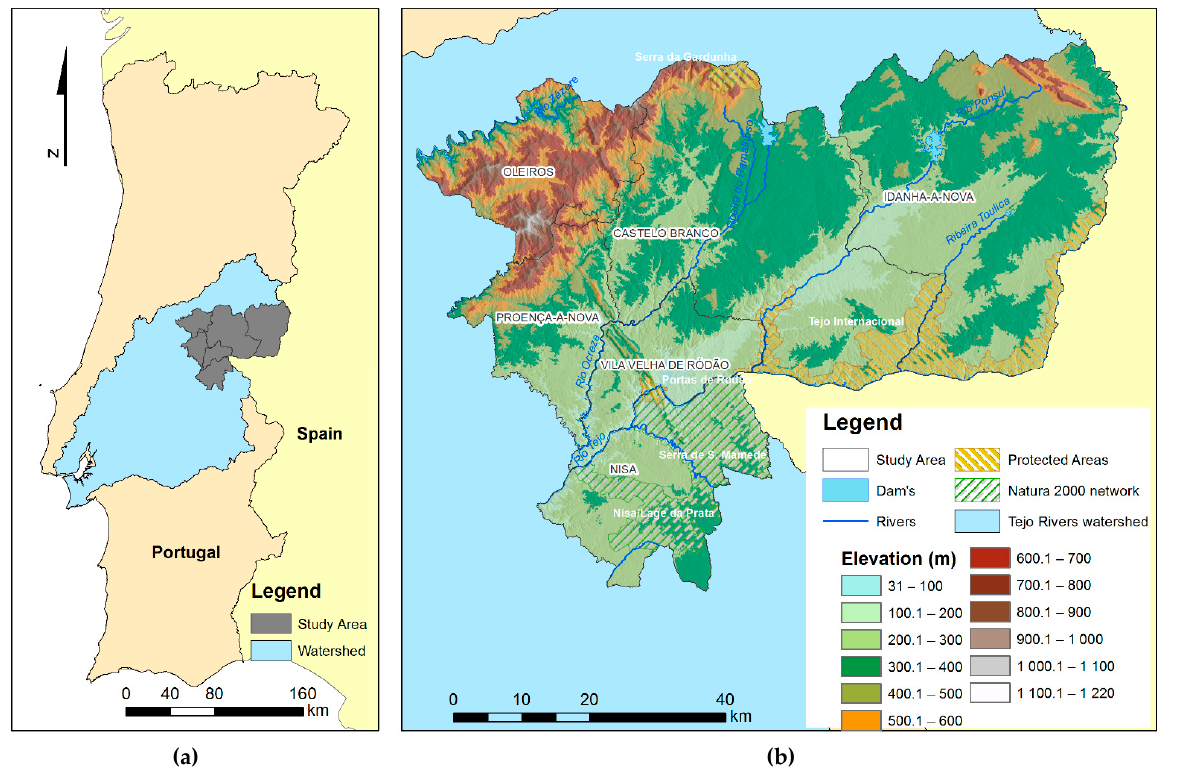
Figure 1. ( a ) Study area: Naturtejo Geopark and Tagus watershed; ( b ) elevation map with the municipalities of: Oleiros, Castelo Branco, Idanha-a-Nova, Proença-a-Nova, Vila Velha de Rodão and Niza; main rivers (Tagus River, Zêzere, and Ocreza); dams (St.ª Agueda and Marchal Carmona); protected areas (Tejo Internacional and Serra de São Mamede, Monumento Natural da Serra da Gardunha e Portas de Rodão); Natura 2000 Network (Serra da Gardunha, Serra de São Mamede, and Niza/Lage da Prata).